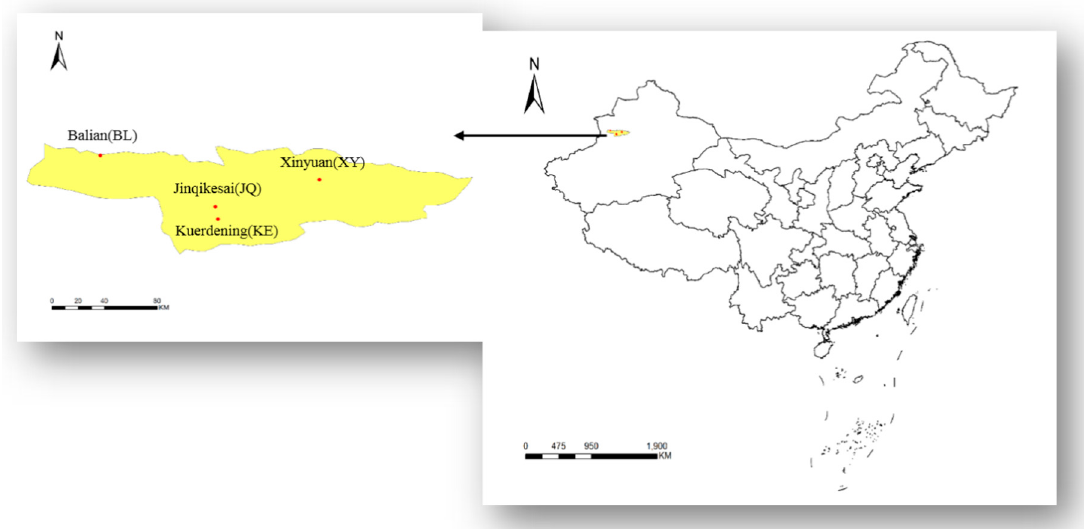
Figure 2. The four plots located in Xinyuang, Gongliu county, China.